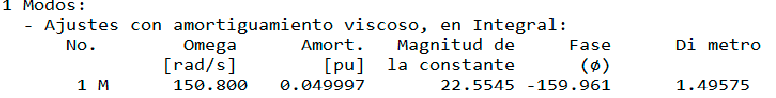
Figure 6. Adjusted modal parameters when an imaginary sensor has an angular position of 20°.